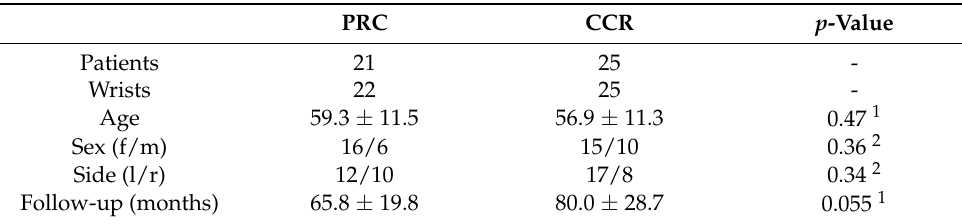
Table 1. Patient Demographics.